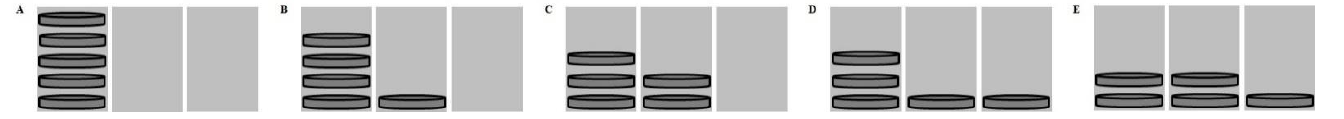
Figure 2. All possible kinds of configurations for the five-disc Tower of London task. Table 3. Description of the trials in Tower of London (TOL) task in two timepoints (Time 1 and 2). Time 1 Time